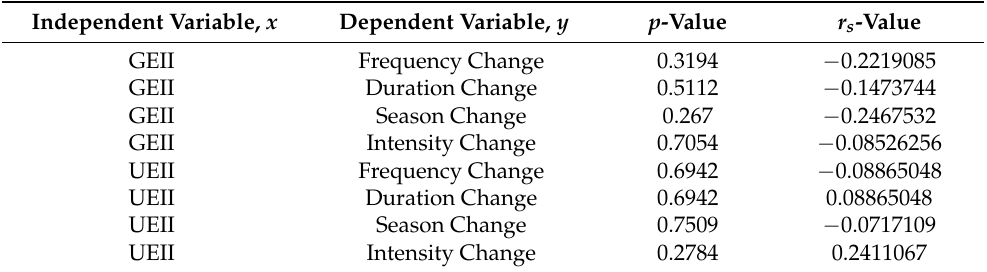
Table 12. Spearman correlation between UEII, GEII, and heatwave frequency, duration, season, and intensity for 22 cities in the South Region.